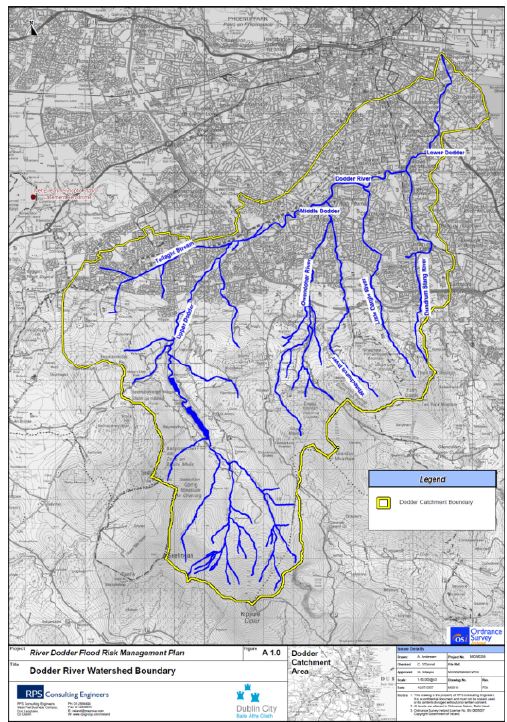
Figure 2. River Dodder Catchment (source: River Dodder Flood Risk Management Plan, Dublin City